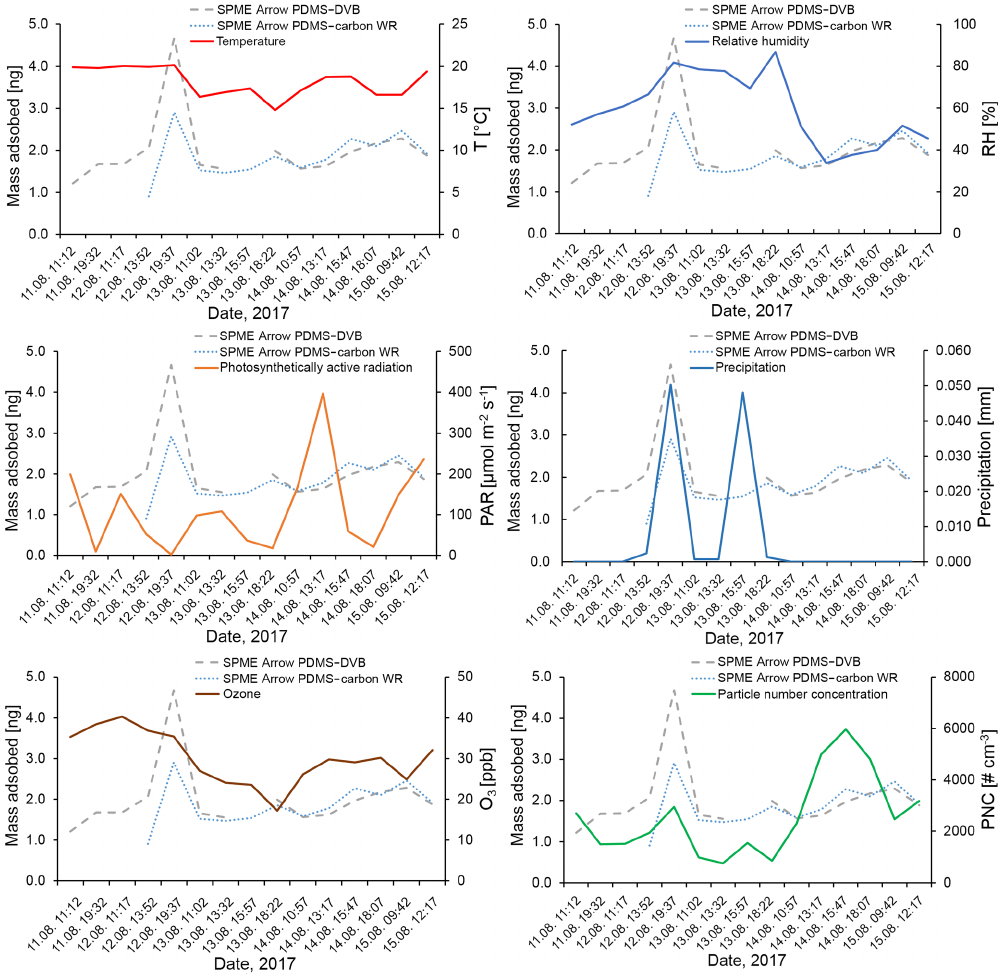
Figure 9. Effect of temperature ( ◦ C), relative humidity (%), photosynthetically active radiation (µmolm − 2 s − 1 ), precipitation (mm), ozone (ppb), and particle number concentration (#cm − 3 ) on the mass of monoterpenes adsorbed on the SPME Arrows used in this study (PDMS– DVB and PDMS–carbon WR) and measured by